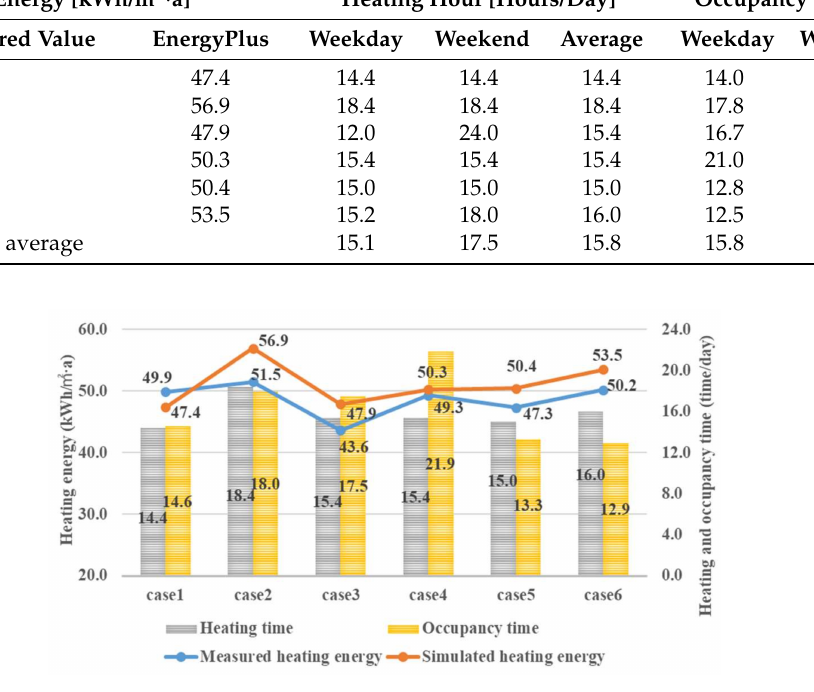
Figure 17. Comparison between the measured heating energy consumption and simulation as well as living pattern (case